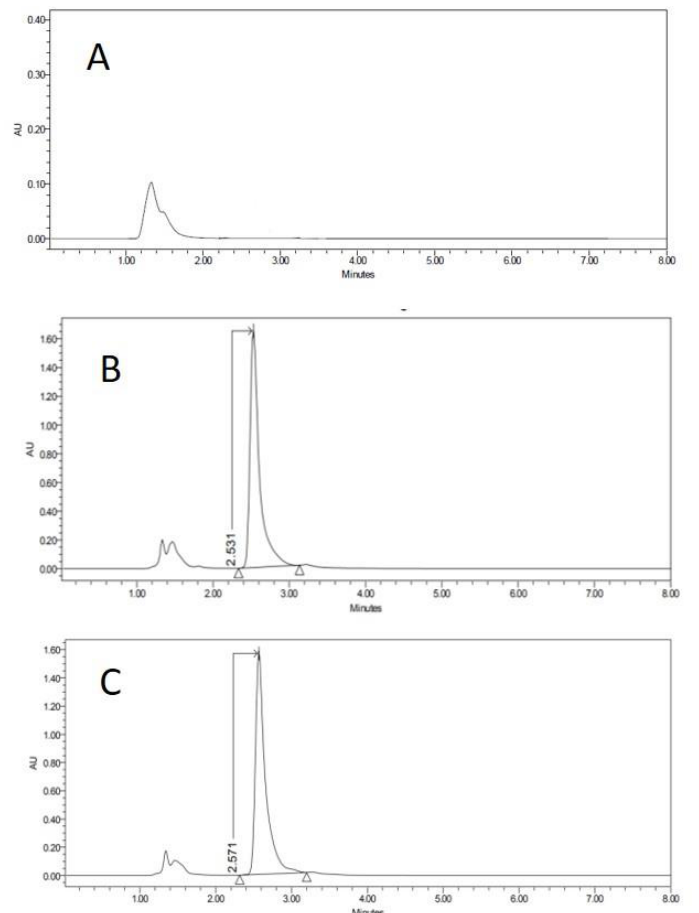
Figure 3. HPLC chromatograms of blank of PBSm ( A ), PBSm spiked with carprofen ( B ) and receptor solution after 6 h of vagina permeation ( C ). Y-axis in the figure is expressed in arbitrary units (AU). Table 1. Linearity test of the concentration range of both curves, accuracy and precision of minimum, medium and maximum concentration value and detection and quantification limits of the chromatographic quantification of carprofen.